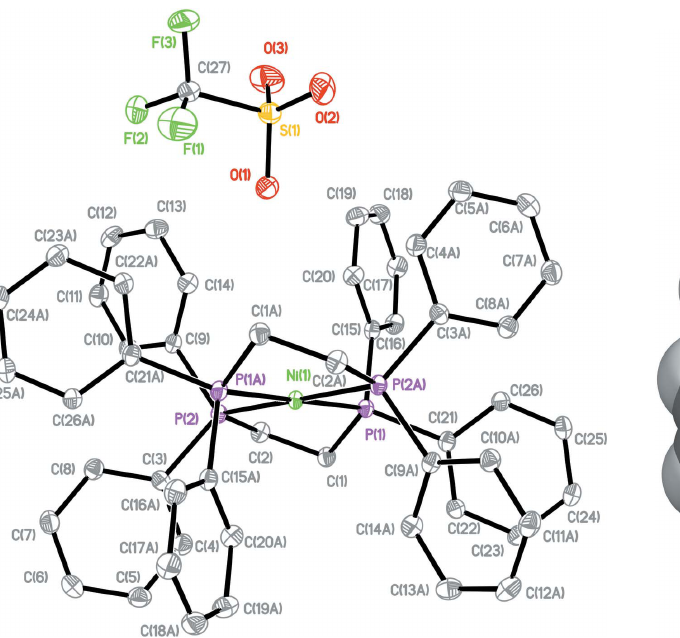
Figure 3 View parallel to the coordination plane of the Ni and P atoms, showing the counter-ions blocked by the phenyl rings. A space-filling rendering was used for the phenyl groups, the Ni atom and the oxygen atom pointed towards Ni. The disordered part of the anion is omitted for